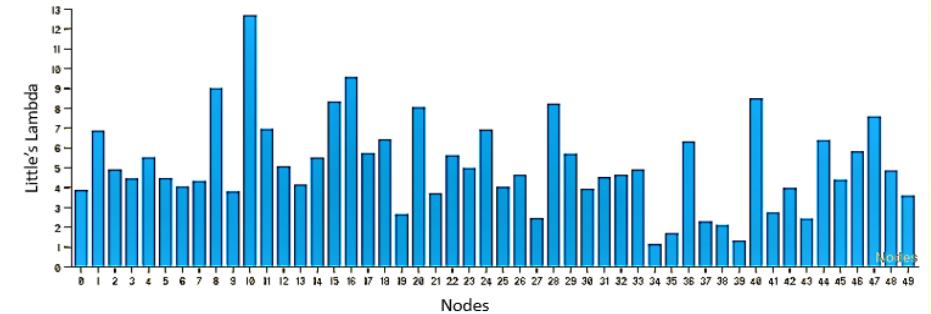
Figure 14. Little’s results of the nodes